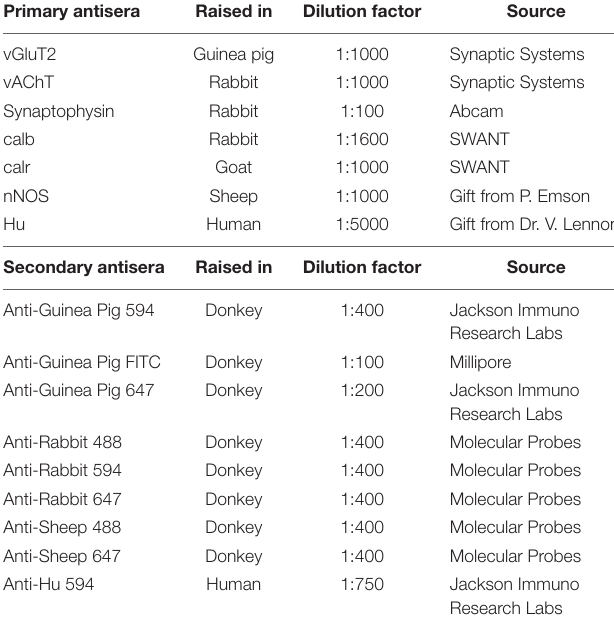
TABLE 1 | Primary and secondary